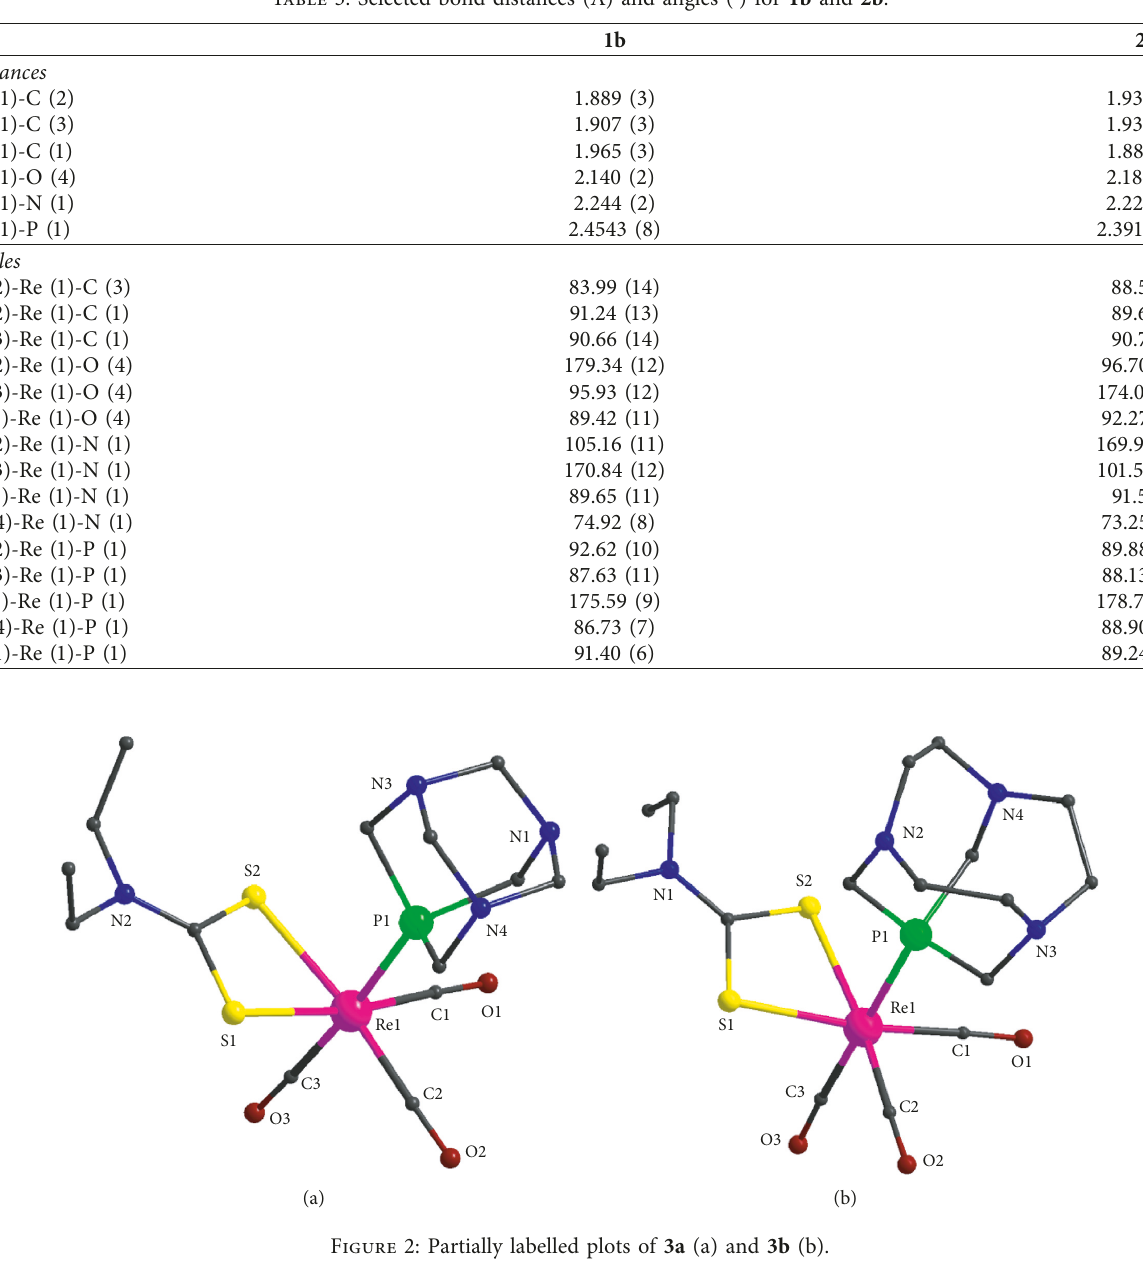
Table 3: Selected bond distances (˚A) and angles ( ° ) for 1b and 2b .